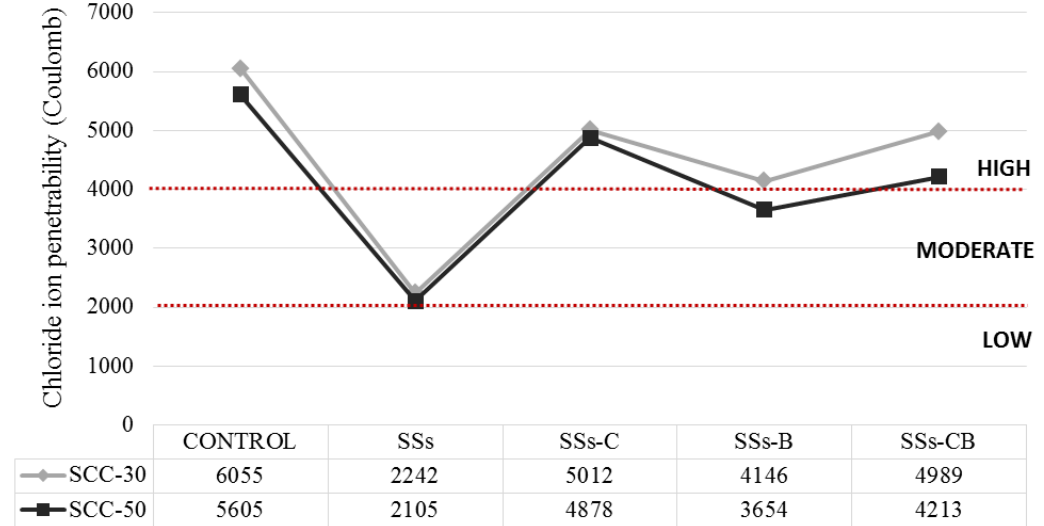
Figure 9. Chloride ion penetration test at 28 days of series SCC-30 and SCC-50.